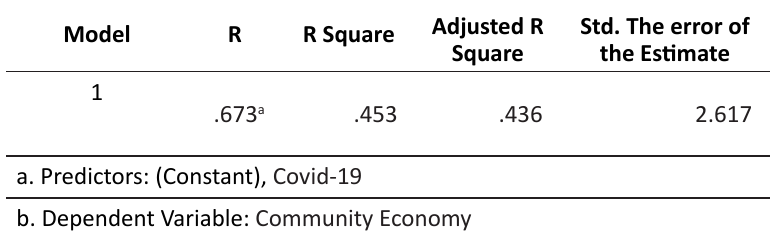
Table 8: Results Of The Coefficient Of Determination